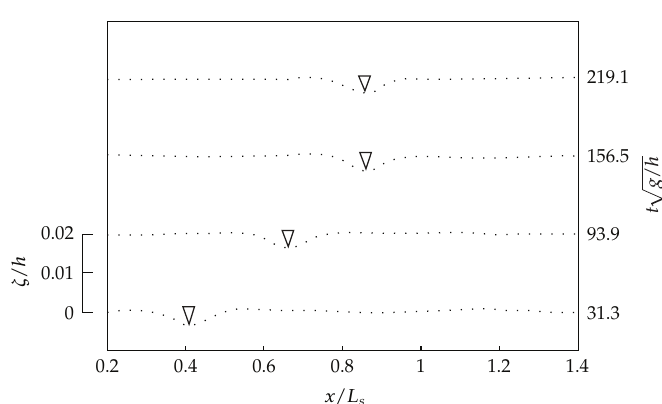
Figure 13: Time variation of surface profile due to the point load moving on the floating thin plate, where ζ is surface displacement; κ (cid:7) 1.0; N (cid:7) 2. The mark (cid:2) indicates the position of moving point load.